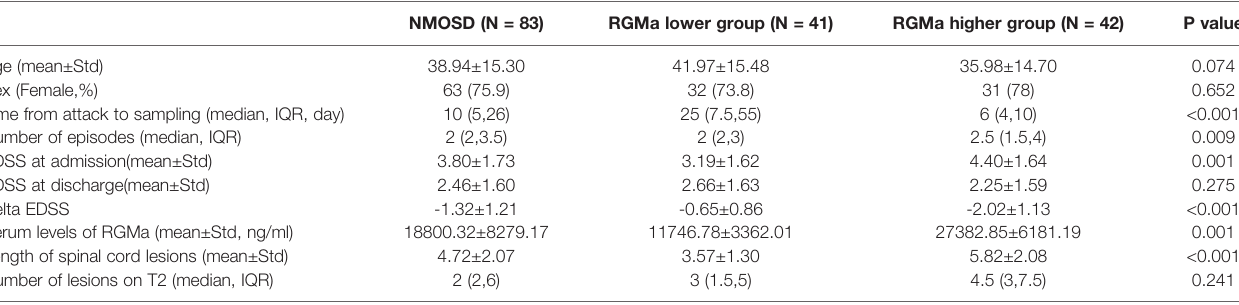
TABLE 1 | Clinical data of patients with NMOSD.